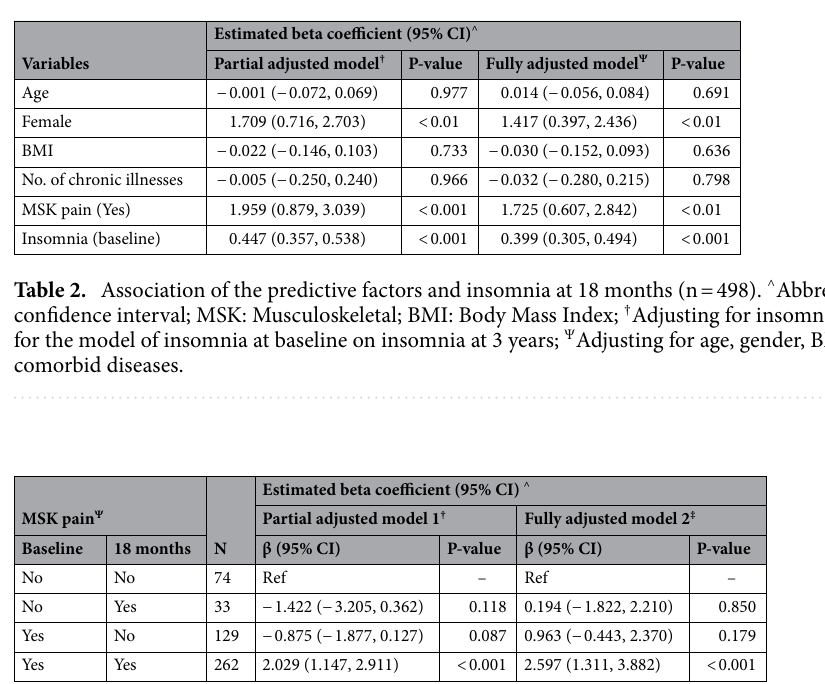
Figure 1. The transition of MSK pain from baseline to 18-month later among 498 people and the corresponding ISI. Abbreviations: MSK: musculoskeletal; ISI: Insomnia Severity Index; M: mean; SD: standard deviation.